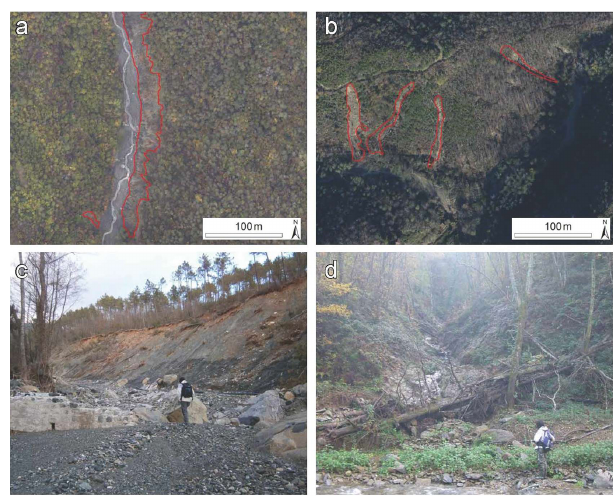
Figure 11. Example of lateral inputs (marked in red in the orthopho- tos, a, b ) of sediment to the channel. In the Gravegnola (a, c) the lateral input consists in large landslides connected to the channel, while in the Pogliaschina (b, d) the connectivity of sediments from the slopes is lower because it mostly occurs through earth flows, which are partly buffered by valley floors, and channelized erosion in ephemeral streams that are sometimes blocked by LW